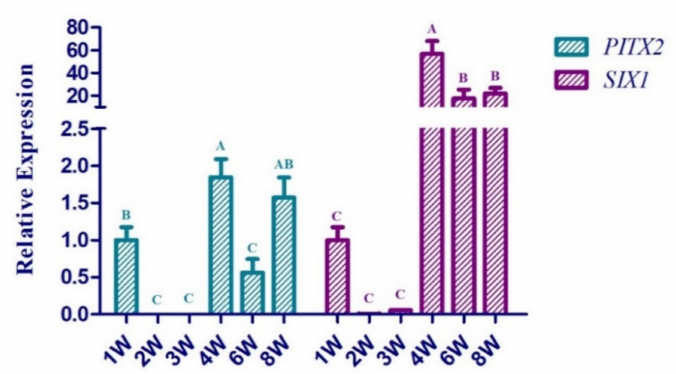
Figure 1. Relative mRNA expression levels of chicken PITX2 and SIX1 genes in the pectoral muscle at different weeks (n = 10 per week). Bars in the same group ( PITX2 or SIX1 gene) with different capital letters indicate a highly significant difference ( p < 0.01), and with the same capital letter indicate no significant difference ( p < 0.05). Data are shown as the mean ±